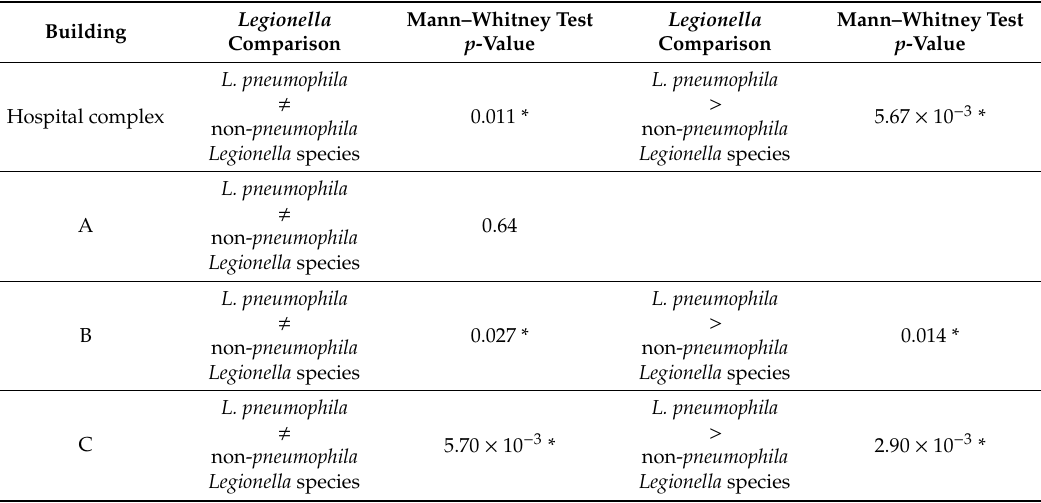
Table 3. Comparison of means between L. pneumophila and non- pneumophila Legionella species in